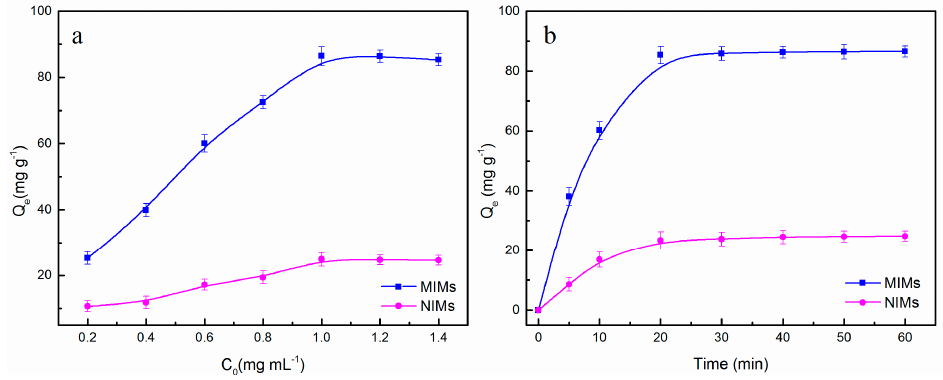
Figure 5. Adsorption isotherm of MIMs and NIMs with Cyt c ( a ); Adsorption dynamic curves of MIMs and NIMs with Cyt c ( b ).